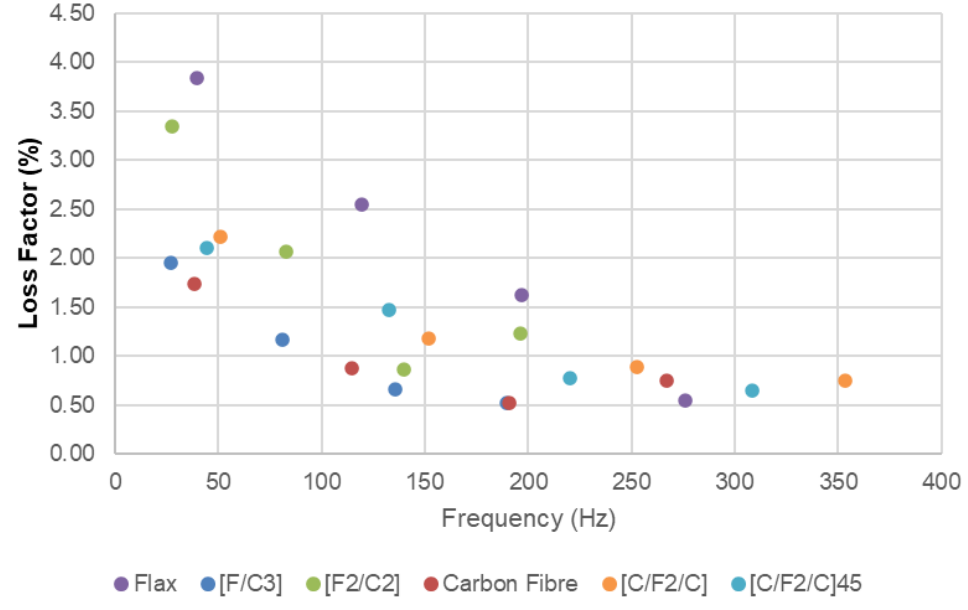
Figure 9. Loss factor vs frequency for all specimens investigated.